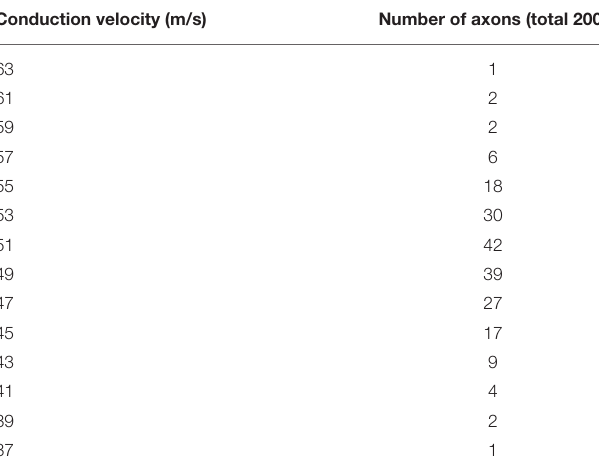
TABLE 1 | Distribution of conduction velocities in a normal model